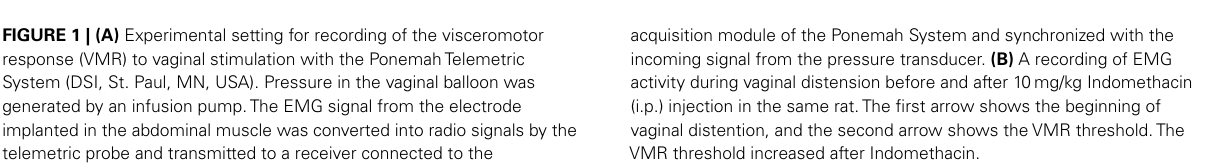
acquisition module of the Ponemah System and synchronized with the incoming signal from the pressure transducer. (B) A recording of EMG activity during vaginal distension before and after 10mg/kg Indomethacin (i.p.) injection in the same rat.The first arrow shows the beginning of vaginal distention, and the second arrow shows theVMR threshold.The VMR threshold increased after